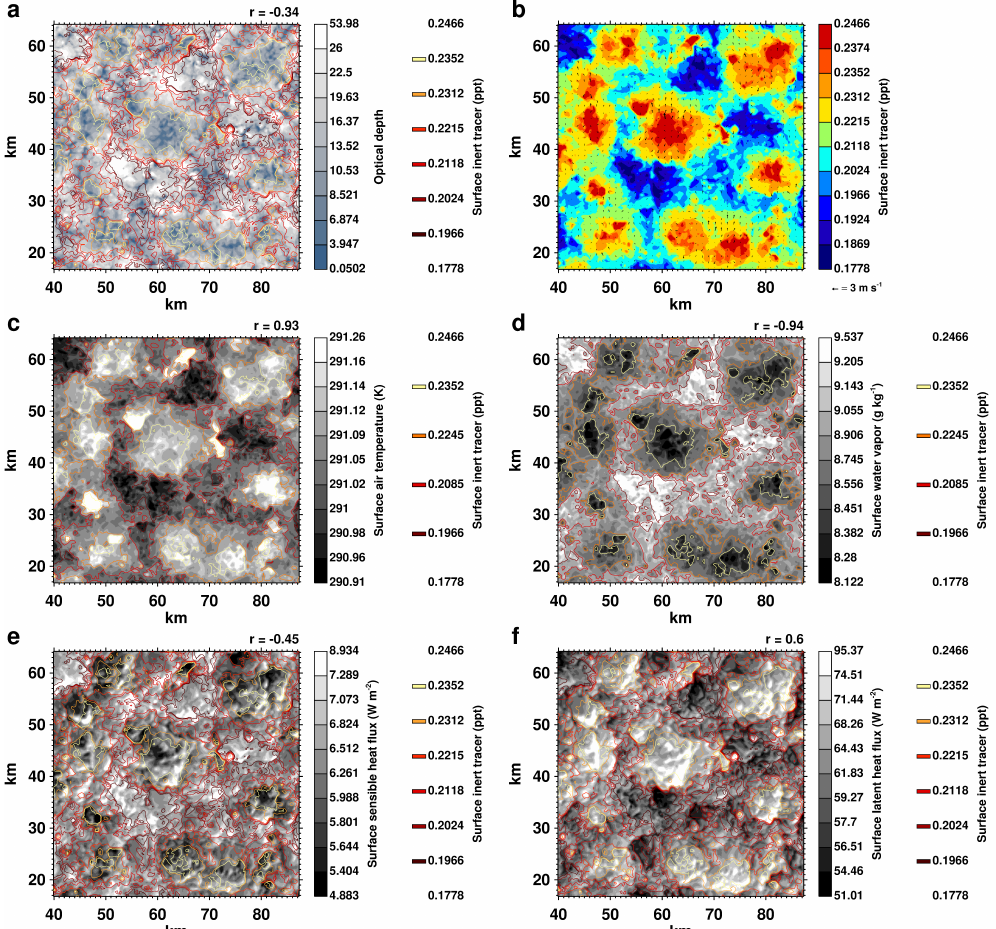
Fig. 10. Surface mixing ratio of the inert tracer, with (a) cloud optical depth, (b) residual horizontal surface wind field, (c) surface air temperature, (d) surface water vapor, and surface sensible (e) and latent (f) heat flux, after 12h in a select region of simulation S • . Domain- wide correlation coefficients are given for pairs of scalar quantities. Irregular contour intervals (at select percentiles of the data) are used for better visualization. Color scales are bounded by minima and maxima of the data. Minimum and maximum line contours are suppressed. The corresponding spatially filtered data are shown in the Supplement, Fig.